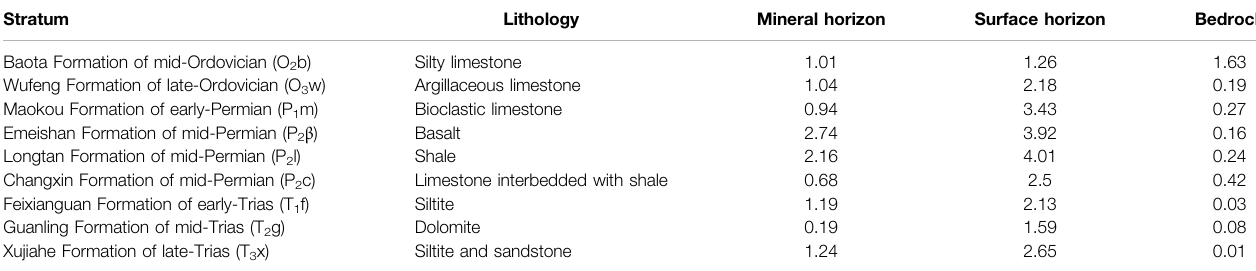
TABLE 2 | Average SOC contents on different bedrocks (%).